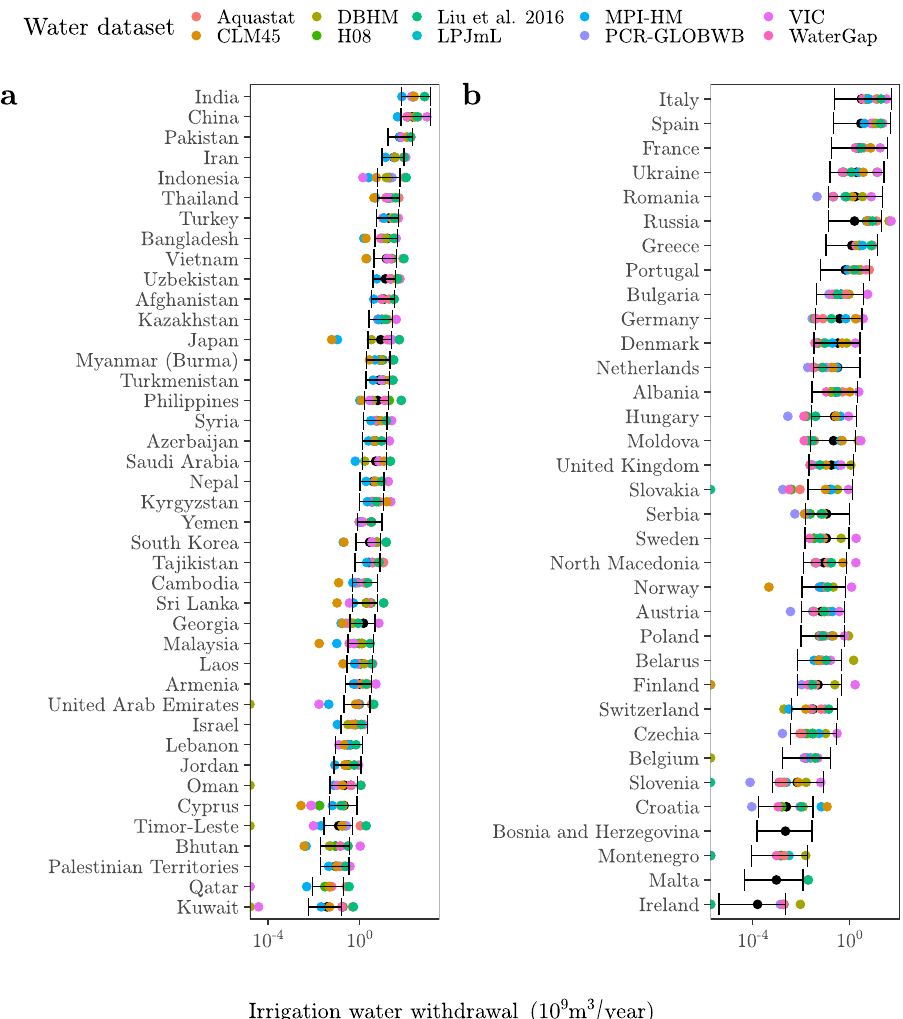
Fig. 4 Comparison between our predictions and the GMs estimations. The black dots and the error bars show the median, the minimum and the maximum irrigation water withdrawal values predicted from the irrigated areas reported by the FAO-GMIA 96 (Methods). The coloured dots show the irrigation water withdrawal estimates outputted by the GMs (DBHM, H08, LPJmL, MPI-HM, PCR-GLOBWB, VIC, CLM45, WaterGap) or reported by the FAO-based datasets (Aquastat, Liu et al. 19 ). a Asia. b